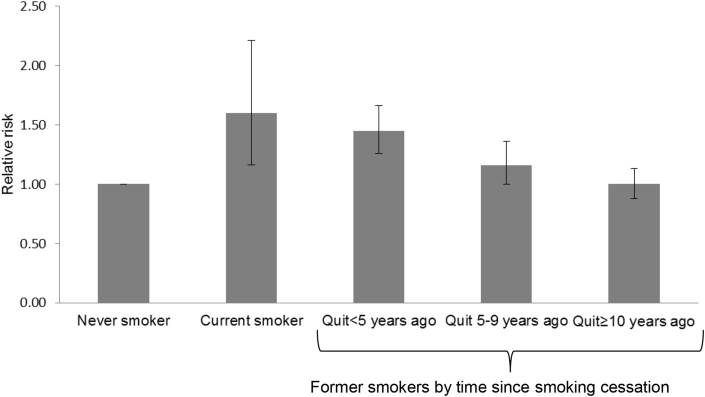
Relationship between duration of smoking cessation and relative risk of diabetes. Data were pooled using random-effects meta-analysis from three studies that presented data for duration of smoking cessation. Error bars show 95% confidence intervals.